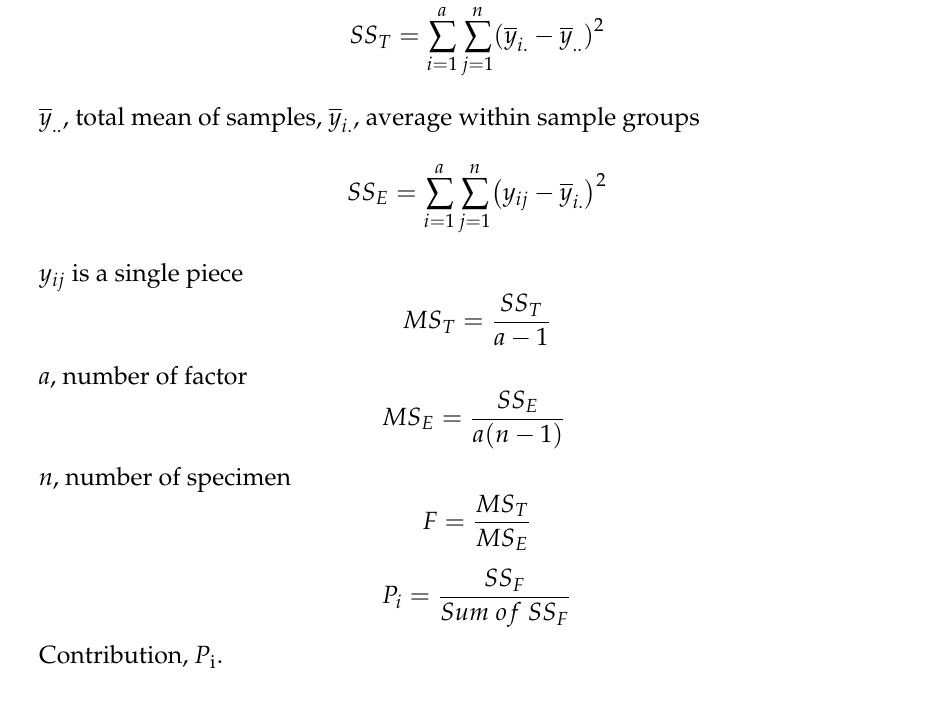
Table 6. Response table of signal-to-noise ratio and ANOVA analysis for tensile